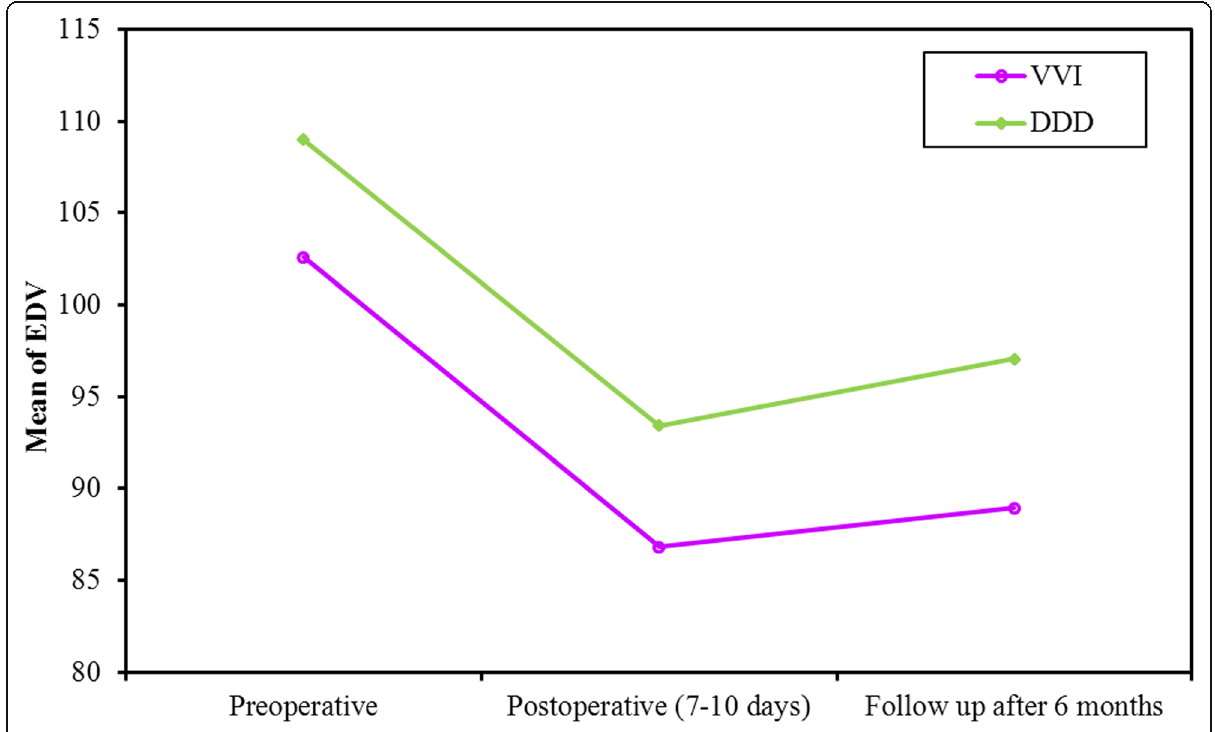
Fig. 4 Comparison between the different periods according to EDV in each